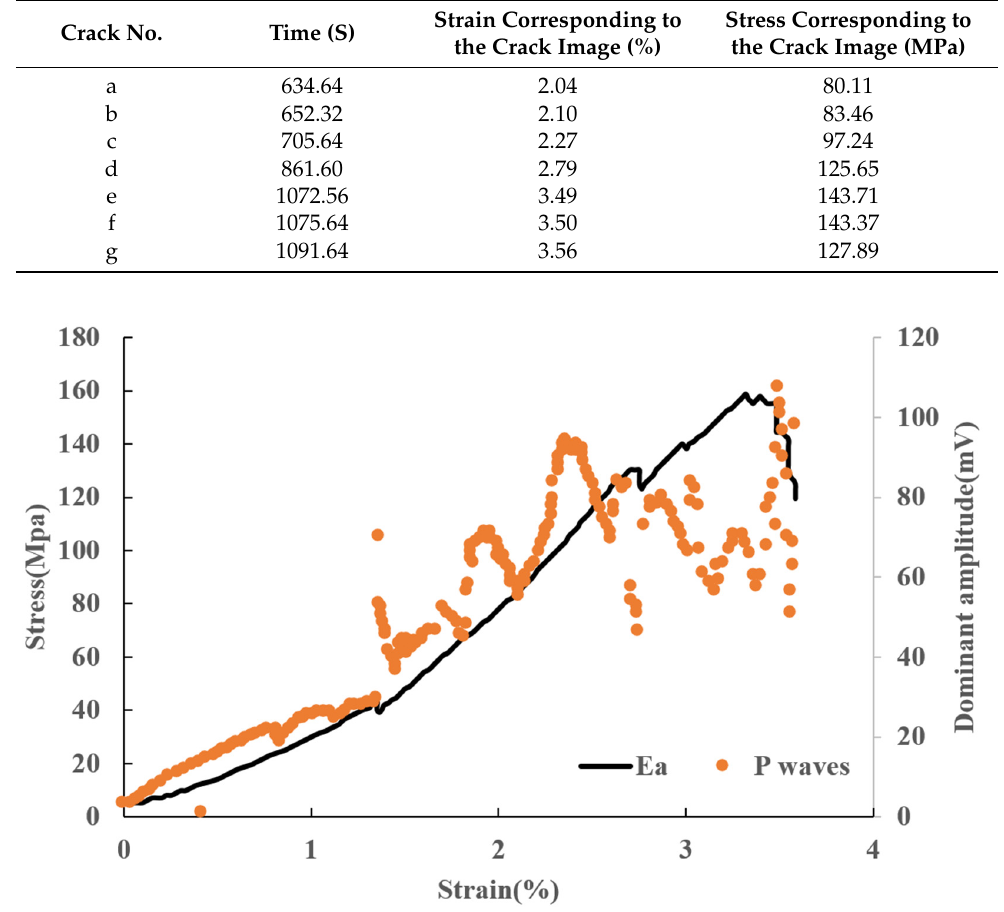
Figure 8. Stress–strain-dominant amplitude of the square shale sample (z-0-6).